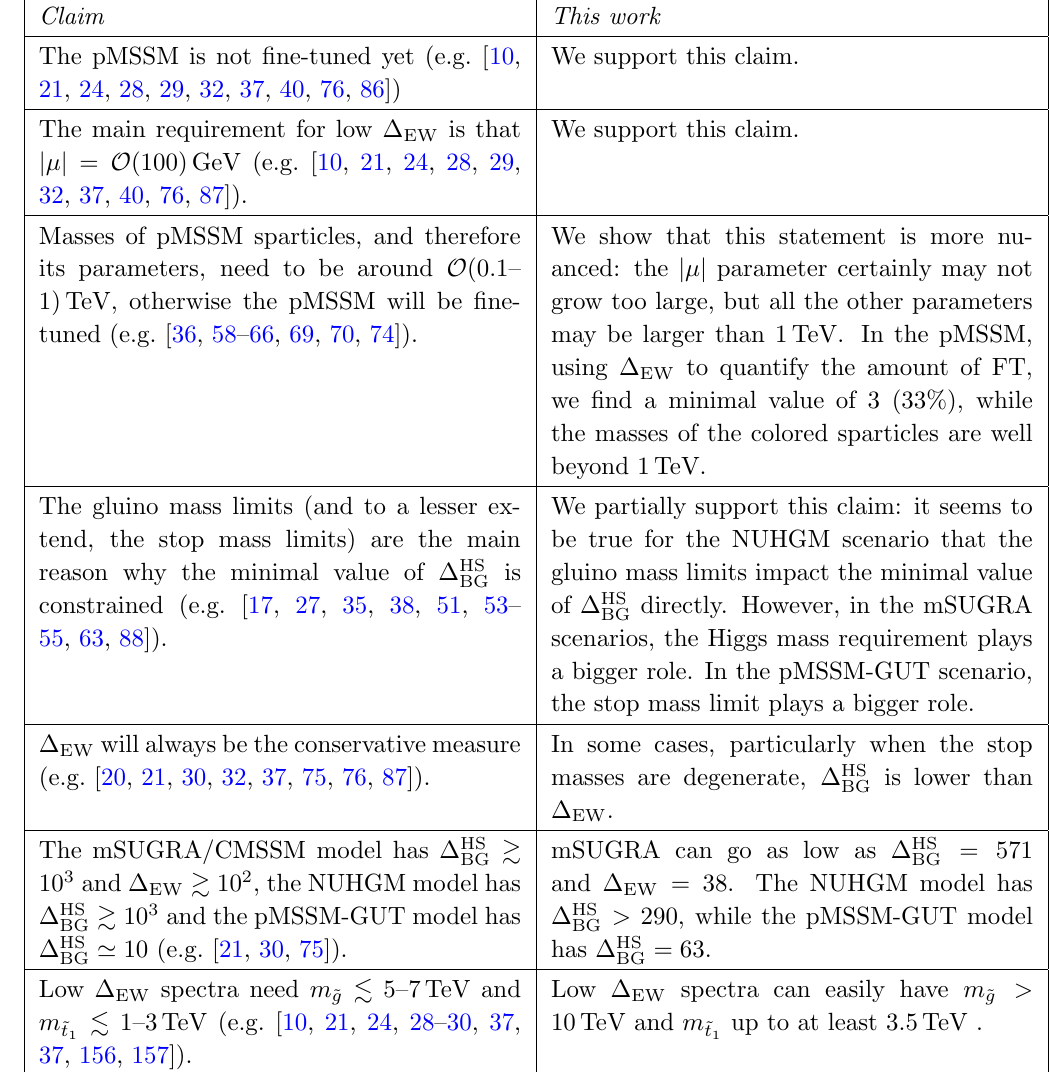
Table 3 . Comparison of claims that are commonly made in the FT literature (after the discovery of the Higgs boson) with our